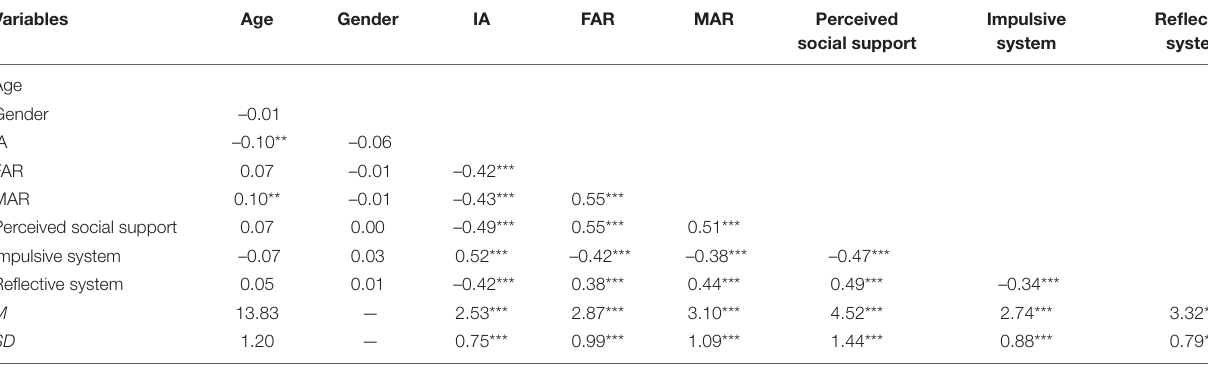
TABLE 1 | Descriptive statistics and correlations for key variables ( N = 732).